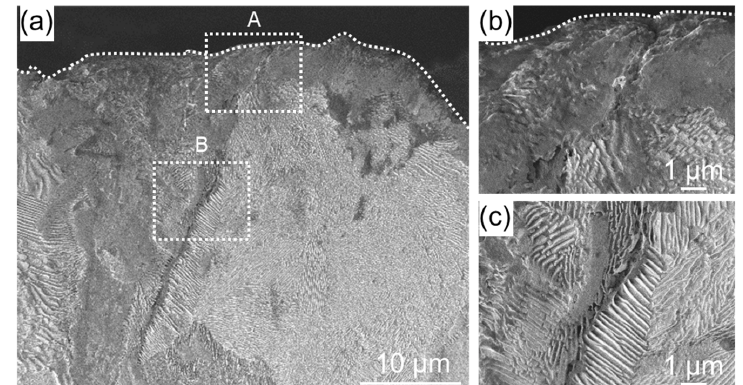
Figure 5. ( a ) Cross-sectional SEM images of a specimen after WJP treatment for 2 min. Enlarged SEM images of the regions indicated by dashed boxes ( b ) A and ( c ) B in ( a ). The dashed lines indicate the specimen surface.